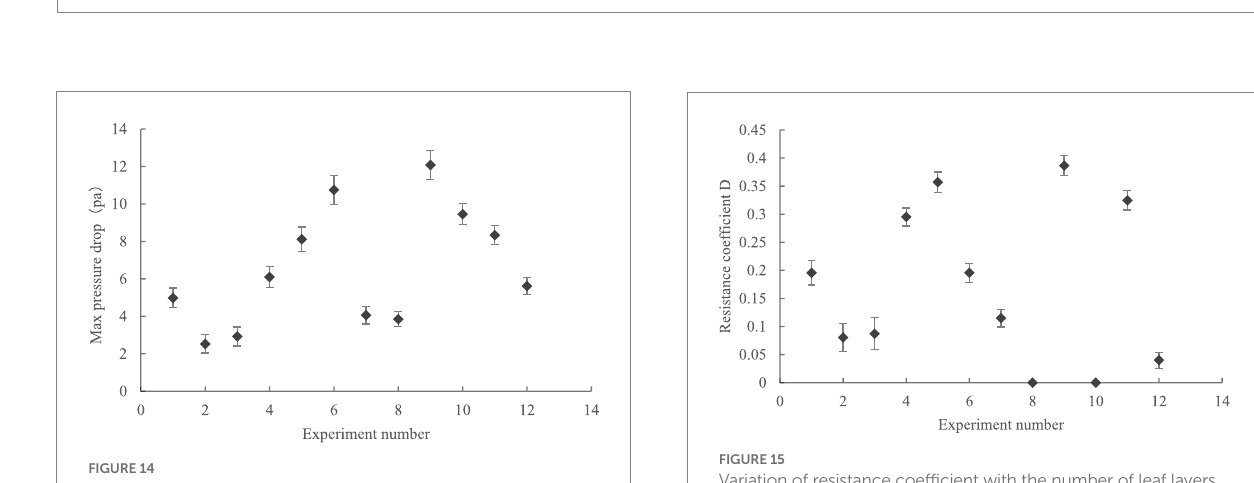
FIGURE 14 Variation of maximum canopy pressure drop with the number of leaf layers and initial azimuth.